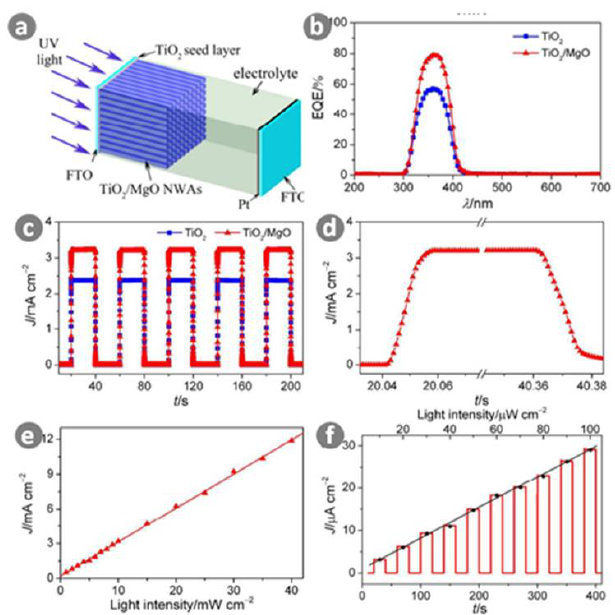
Figure 15. ( a ) Device structure diagram of a photoelectrochemical self-powered UV detector; ( b ) EQE spectra of TiO 2 and TiO 2 /MgO nanowires based UV detectors; ( c ) Photocurrent responses of TiO 2 and TiO 2 /MgO nanowires based UV detectors under on/off radiation of 10 mW/cm 2 UV light illumination ( λ = 365 nm); ( d ) Enlarged rising and decaying edges of the photocurrent response for the TiO 2 /MgO nanowires based UV detectors; ( e ) J as a function of the incident UV light intensity from 1 to 40 mW/cm 2 for the TiO 2 /MgO nanowires based UV detectors; ( f ) Photocurrent responses of the TiO 2 /MgO nanowires based UV detectors under on/off radiation of low UV light density from 10 to 100 µ W/cm 2 . Ref. [128] Copyright 2016, Royal Society of